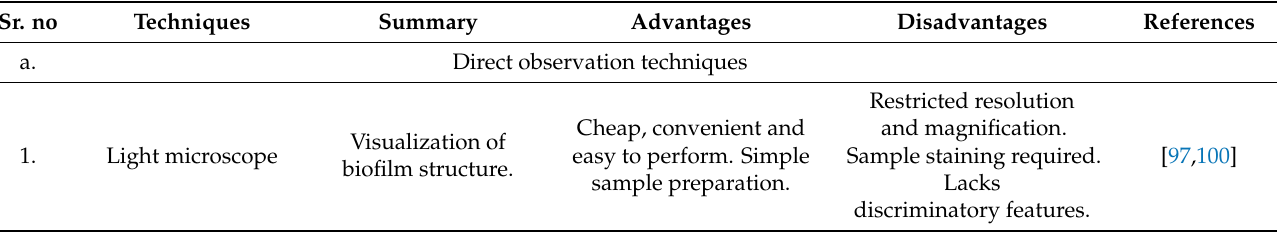
Table 2. Summary of techniques used for biofilm visualization and